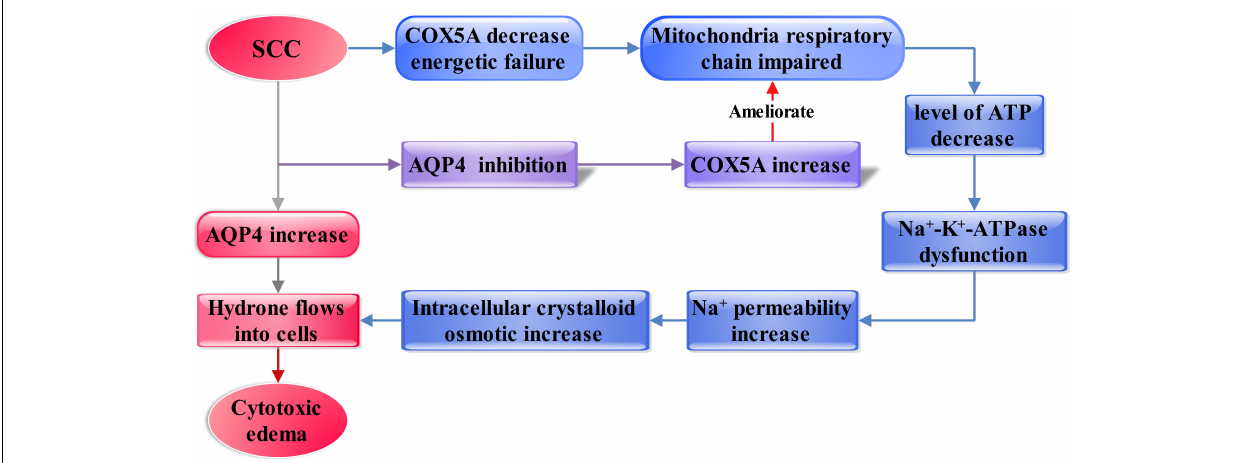
FIGURE 6 | Diagram showing the framework of discussion. The increasing AQP4 influences vascular and cytotoxic edema after SCC (shown as the red and gray arrows). Then, inhibition of AQP4 expression mediated by lentivirus significantly ameliorated cytotoxic edema after SCI. Furthermore, AQP4 is found as a regulator in the cytotoxic edema, probably dependent on regulating the COX5A expressional levels, which may affect membranous Na + -K + -ATPase by regulation of ATP generation (shown as the blue and purple